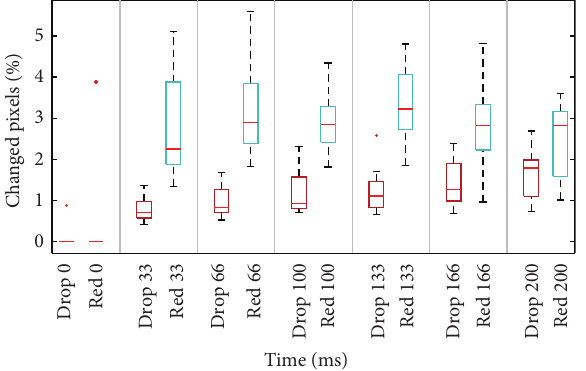
Figure 7: Descriptive statistics of extent of